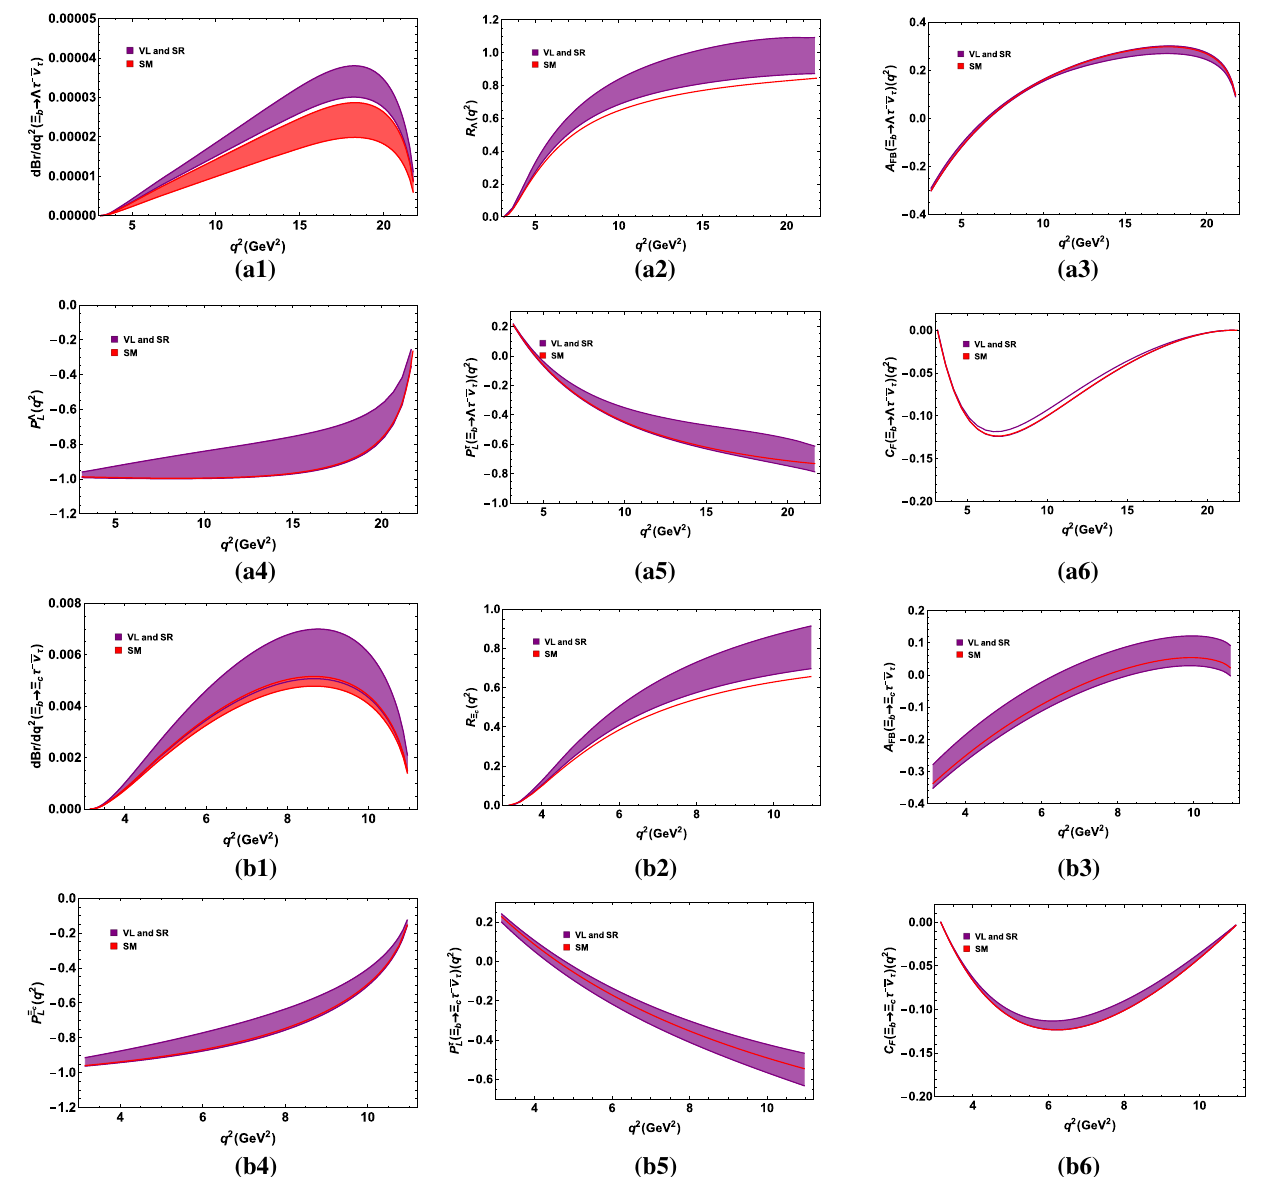
( q 2 ) ( a5 , b5 ) and C l ( q 2 ) ( a6 , b6 ) relative to the decays (cid:2) P τ L F (cid:3)τ − ¯ ν τ and (cid:2) → (cid:2) τ − ¯ ν τ , respectively. The bands contain the theo- b c (cid:3)((cid:2) c ) ( q 2 ) ( a4 , b4 ), retical uncertainty of the CKM matrix elements | V u ( c ) b L